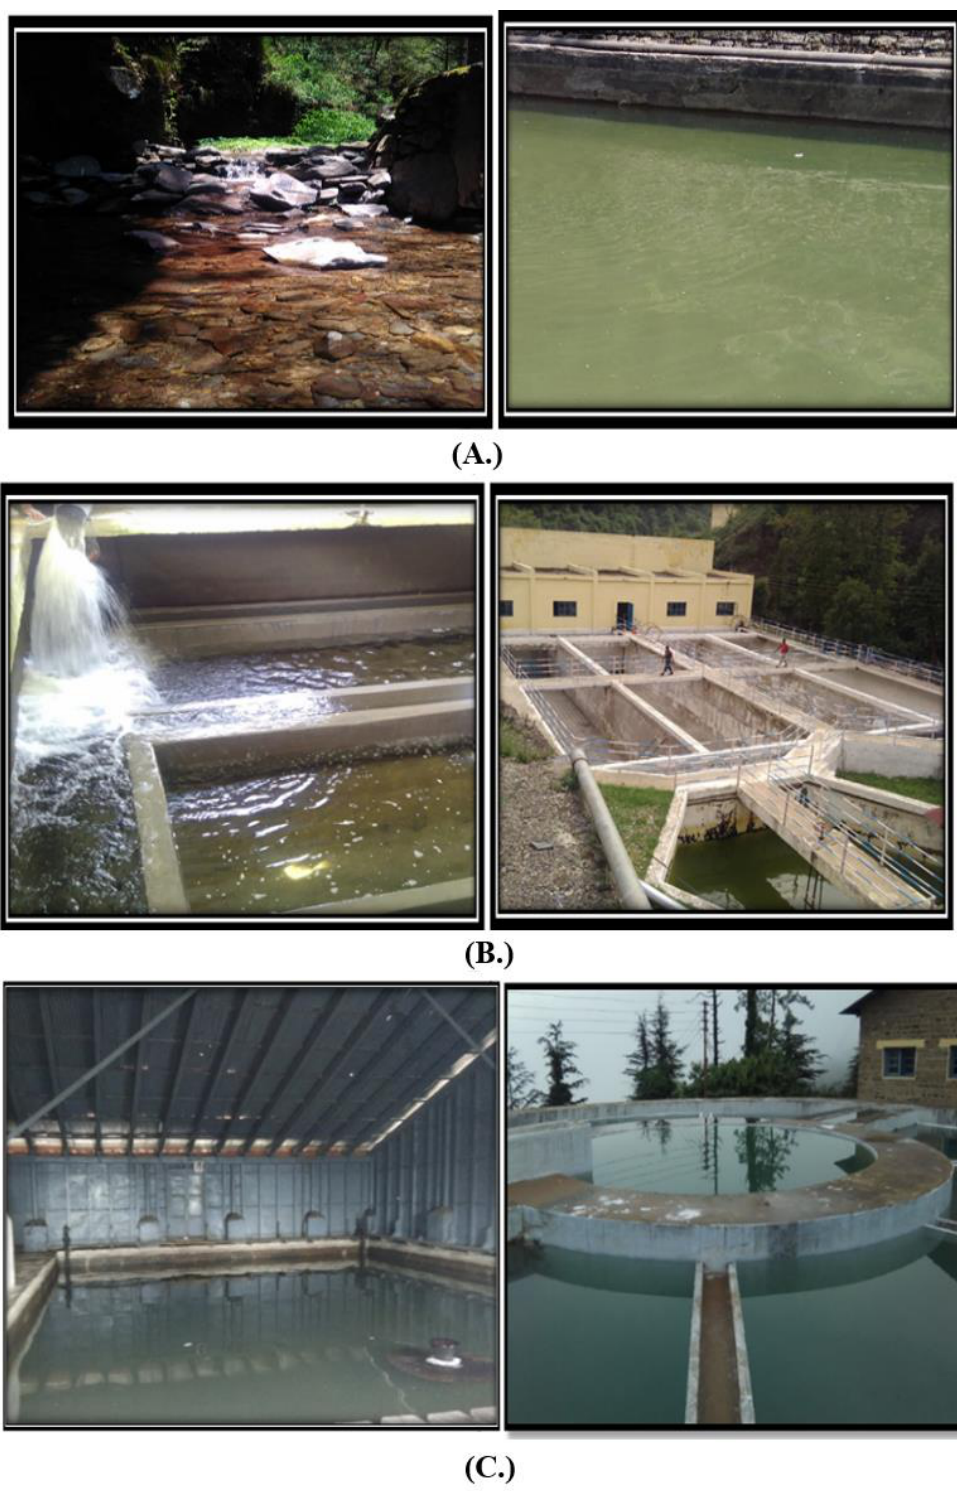
Figure 2. Different sampling sites investigated during course of study. ( A ) Churat Nallah, ( B ) Ashwani Khad hard workers ( C ) Water treatment plant Dhalli.